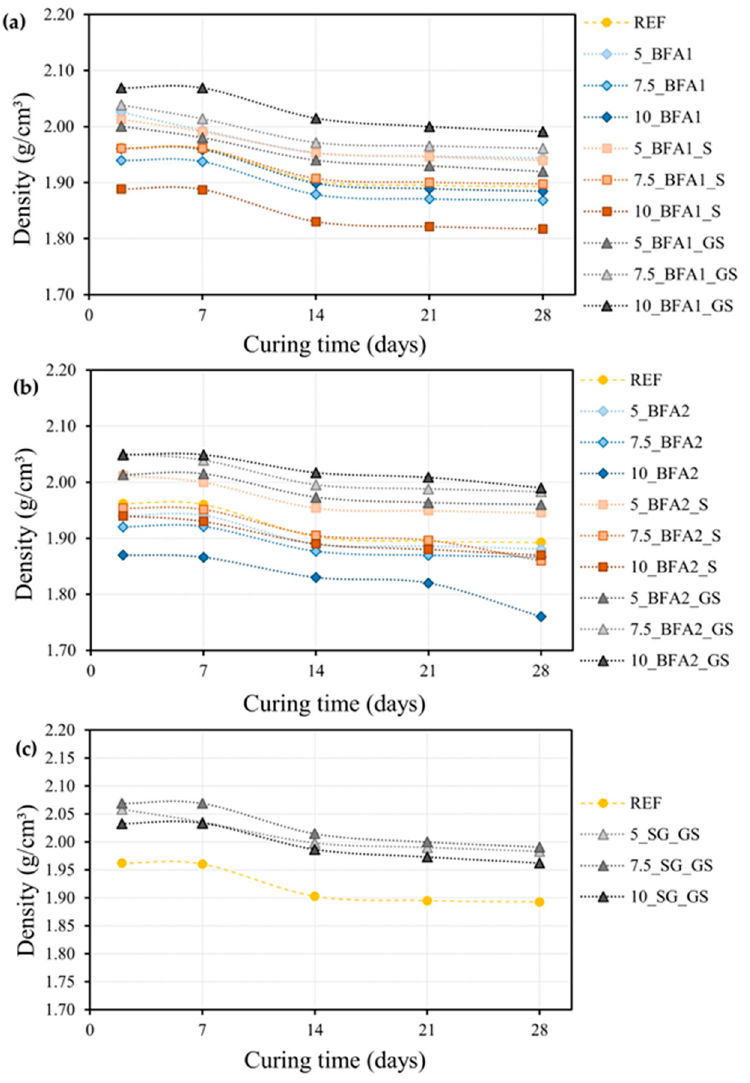
Figure 4. Density behavior of mortars during the 28 days of curing. Samples prepared with: ( a ) BFA1, ( b ) BFA2, and ( c )